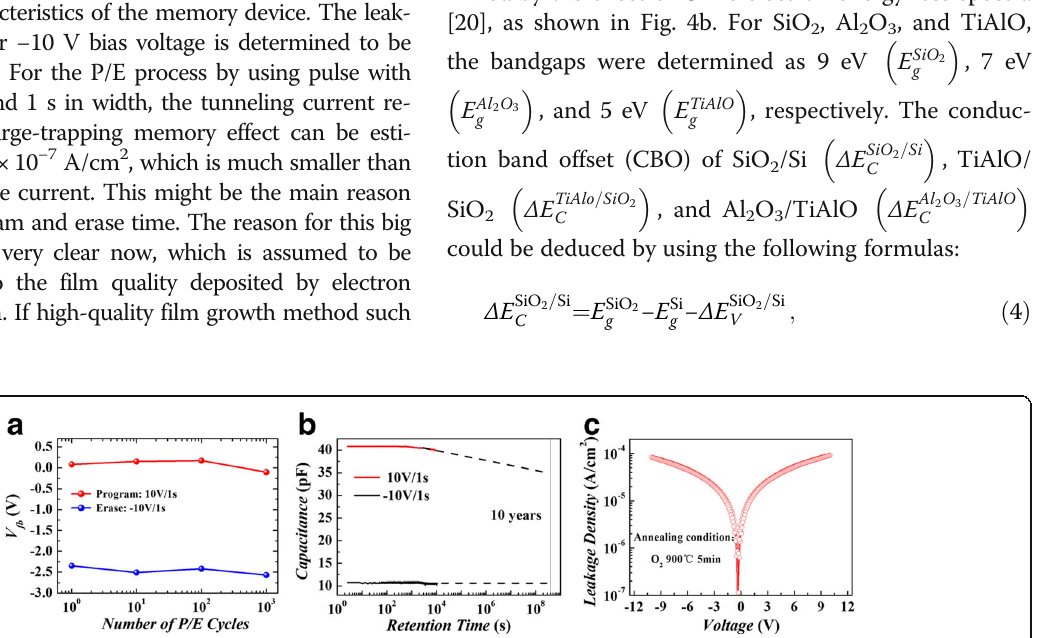
Fig. 3 ( Color online ) The endurance ( a ), retention ( b ), and leakage current-voltage ( c ) characteristics for the Au-Al 2 O 3 -TiAlO-SiO 2 -Si